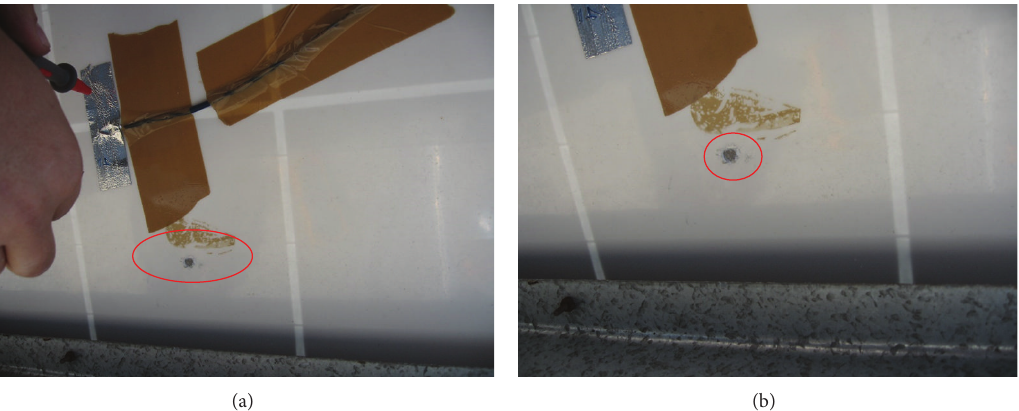
Figure 9: Experimental apparatus: little holes in the PET film of the PV panel to measure the